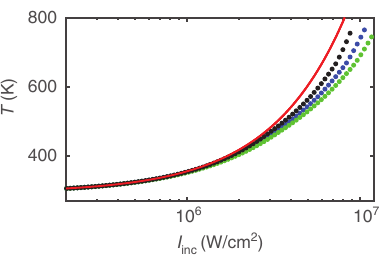
Figure 5: Effect of the temperature dependence of the host thermal conductivity on NP temperature. Calculated temperature for on-resonance case ( λ = 533 nm) for the TIP model (solid red line) and TDP model with temperature-independent thermal conductivity (blue dots), both as in Figure 3, compared to a thermal conductivity that increases with temperature (green dots) and thermal conductivity that decreases with temperature (black dots). In the latter two cases, thermal conductivity changes by as much as